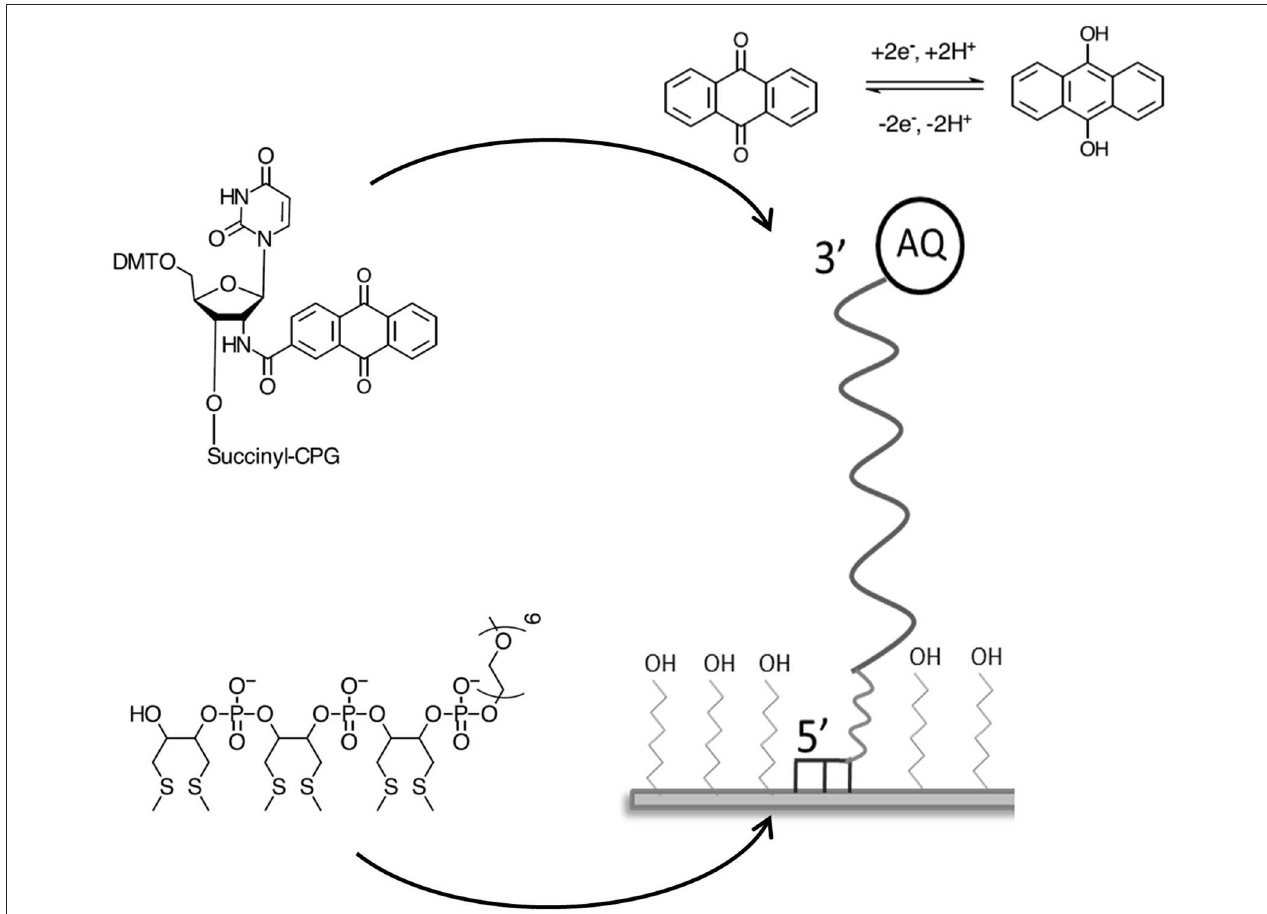
FIGURE 1 | Schematic illustrating the design and format of the AQ DNA hybridization sensor.